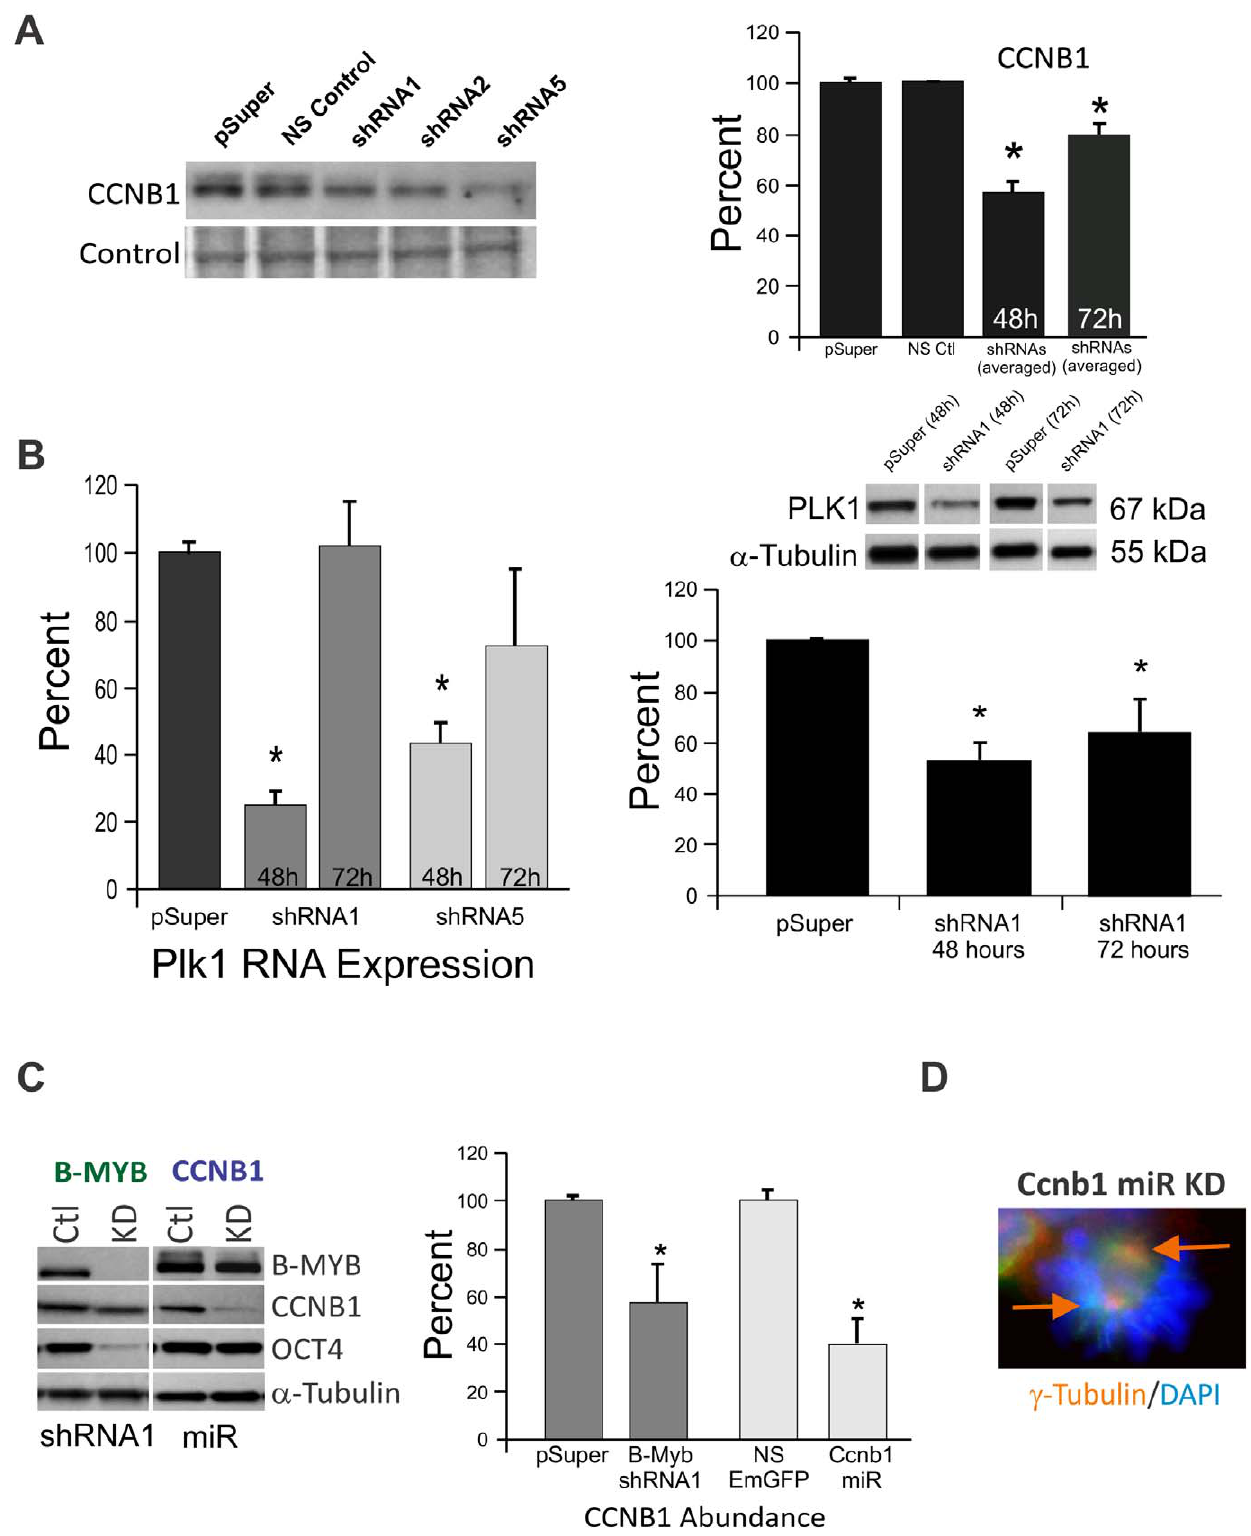
Figure 2. Examination of known somatic cell B-Myb target gene expression patterns following knockdown of B-Myb in ESCs. A) Western blot and graphic presentation of Cyclin B1 (Ccnb1) protein expression following knockdown of B-MYB by shRNAs 1, 2 and 5. B) RNA (left) and protein (right) analysis of the B-MYB target gene Polo-like kinase 1 (Plk1) following B c -Myb KD with shRNA1 and shRNA5. The effects of B-MYB KD on Plk1 RNA were transient; however, the loss of RNA led to a significant and sustained decrease in its protein abundance. C) Western blot and bar graph showing the abundance of selected proteins following knockdown of B-MYB and CCNB1 using shRNAs and microRNAs, respectively. D) Reduced